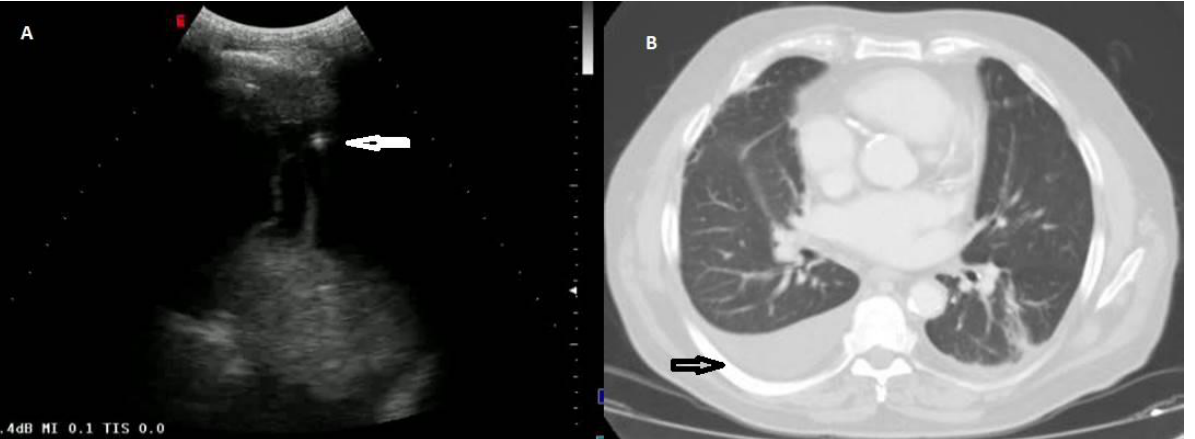
Figure 2. ( A ) TUS scan showing an anechoic effusion with consensual parenchymal atelectasis during thoracentesis with a multifrequency convex probe (3.5 MHz). The tip of the needle is highlighted by a white arrow. ( B ) The corresponding CT scan shows a smooth thickening of the peribronchovascular interstitium and a bilateral pleural effusion with passive atelectasis of lower lobe in the right lung (black arrow).